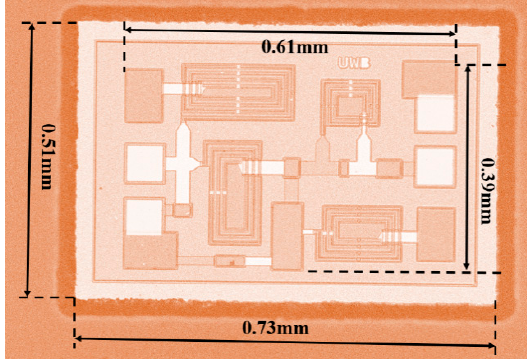
Figure 10. Chip photo of the proposed filter.